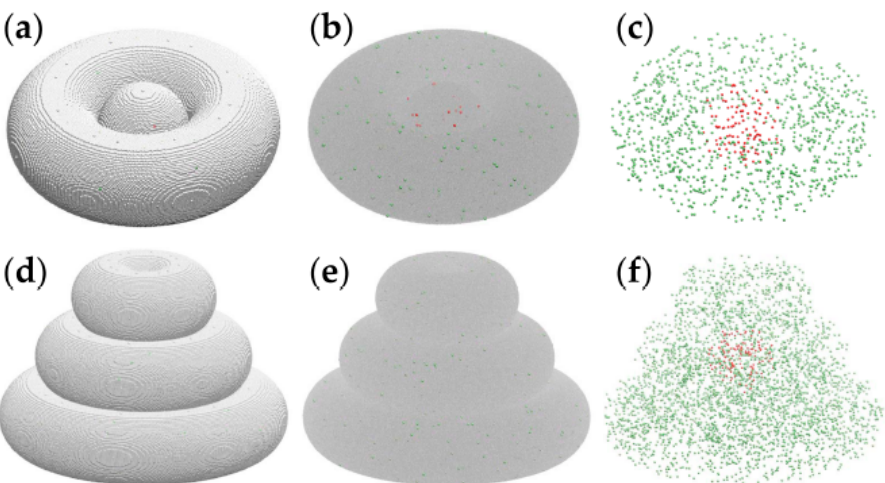
Figure 6. Computational models of the toroidal structure ( a – c ) and triple-layered structure ( d – f ), visualized using VMD [40]. Cancer cells are pictured by red spheres, whereas peritumoral cells are depicted as green spheres. ( a ) The toroidal tissue construct is represented on a cubic lattice, with 1.2×10 6 cell-sized volume elements of the hydrogel pictured as silver spheres. ( b ) The toroidal structure with the hydrogel is shown as a translucent gray medium. ( c ) The cellular components of the toroidal tissue construct (i.e., hydrogel not shown): 109 tumor cells and 1033 peritumoral cells. ( d ) The triple-layered tissue construct, with about 3.8×10 6 volume elements of hydrogel shown explicitly as silver spheres. ( e ) The triple-layered structure with the hydrogel is represented as a translucent continuum. ( f ) The 125 tumor cells and 3716 peritumoral cells are comprised by the computational model of the triple-layered structure.